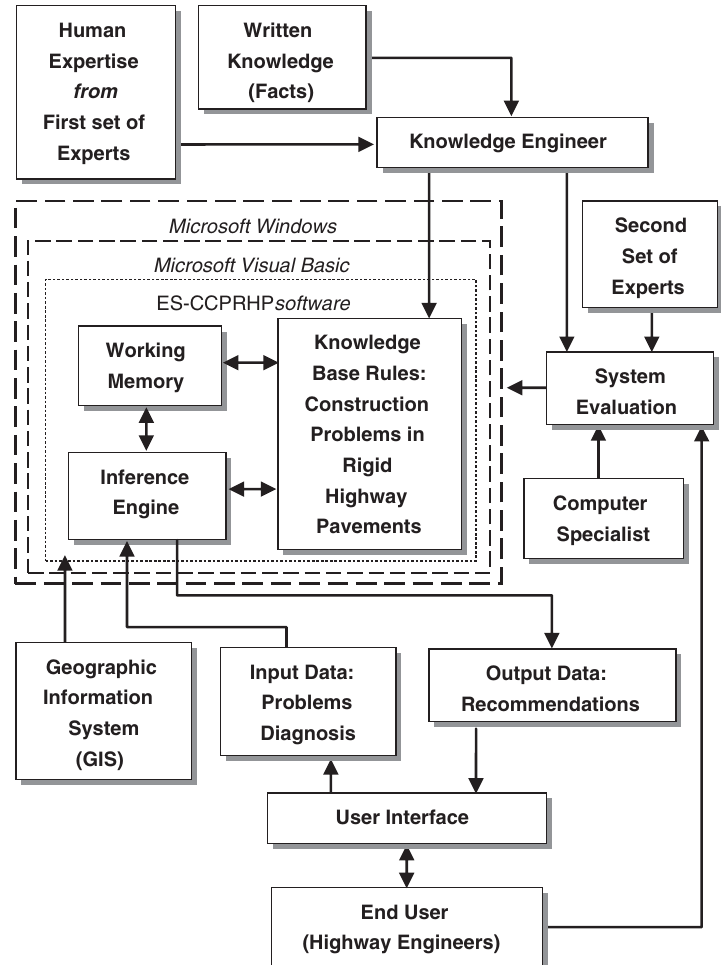
Fig. 2. Relationships among development team and ES-CCPRHP